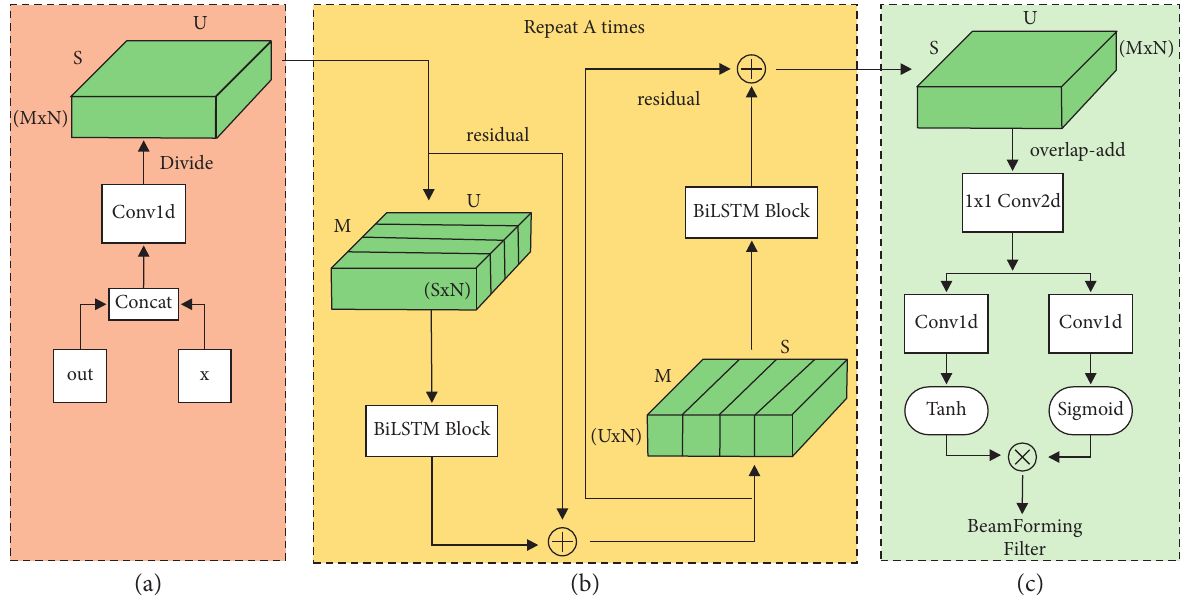
Figure 3: The structure of the TsBiLSTM module and illustration of the proposed module architecture. (a) The input of the TsBiLSTM includes interchannel features and original waveform. (b) The processing chain shows the two-stage BiLSTM with residual connections. (c) Carry out 1 × 1 convolution on the output after overlap-add method operation, then operate conv1d layer with sigmoid and tanh activation function, respectively, and obtain beamforming